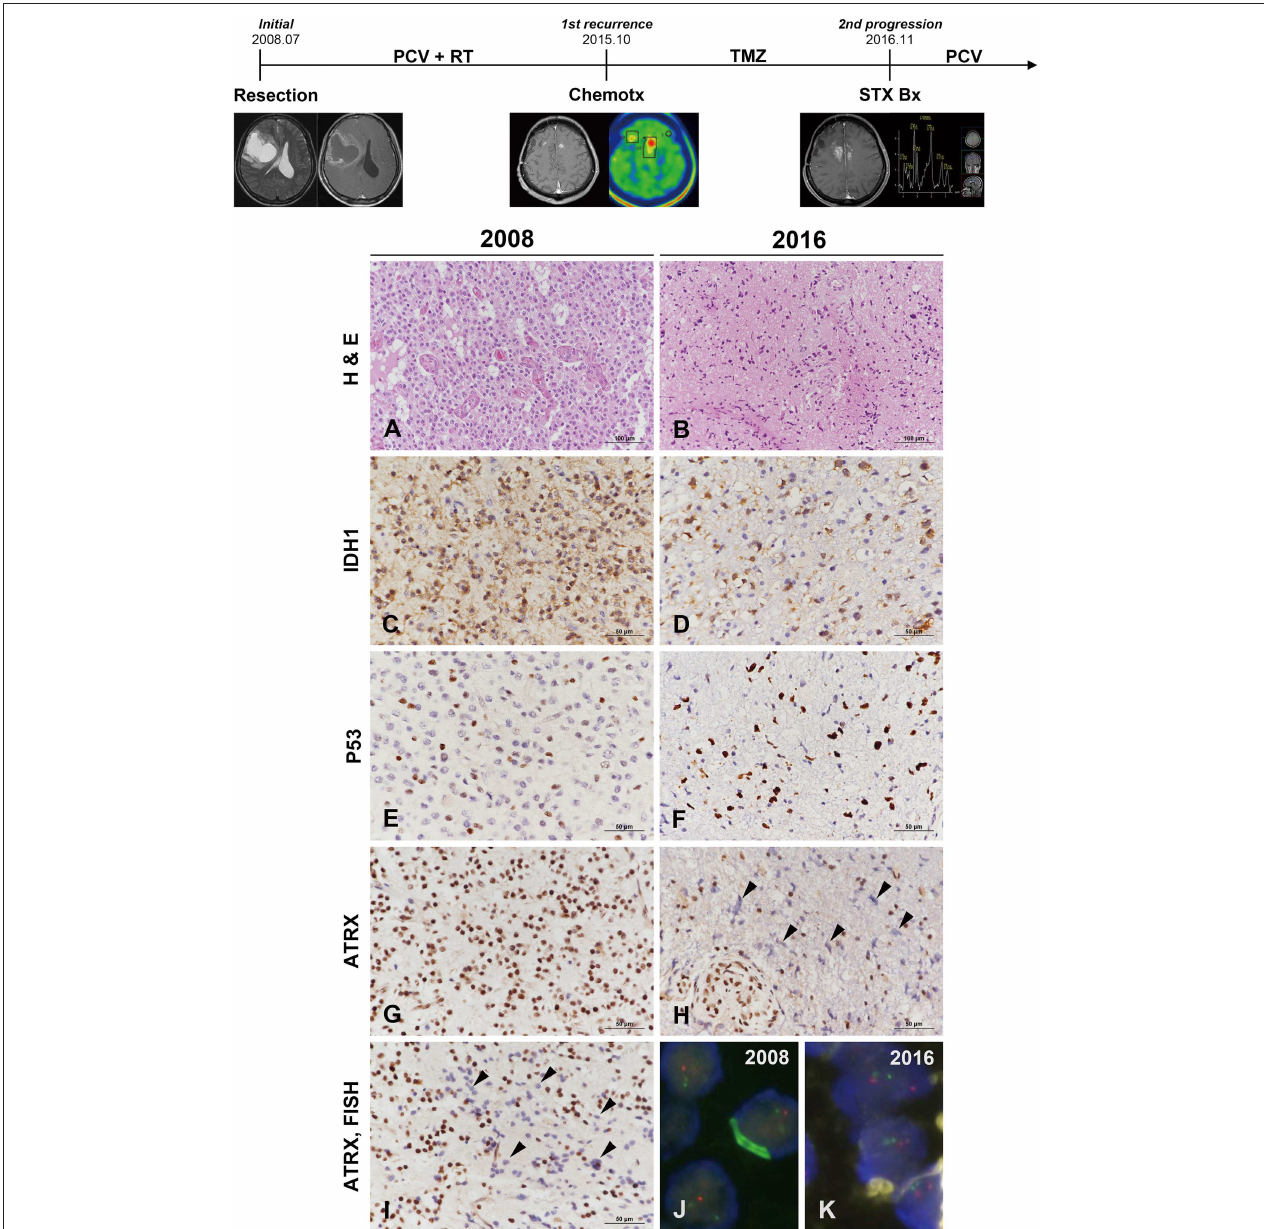
FIGURE 3 | Clinicoradiological and pathological findings in case 2. The clinical progression of case 2 is summarized in uppermost. The original lesion displayed microvascular proliferation among monotonous tumor cells with perinuclear halos in 2008 (A) and then converted to a tumor with marked cytological atypia in 2016 (B) ( A,B , hematoxylin and eosin stain; original magnification, × 200). The tumor cells showed IDH1-R132H positivity by IHC at both occasions (C,D) . P53 immunoreactivity converted from weak heterogeneous positivity of the wild type in 2008 to strong positivity of the mutant type at recurrence (E,F) . ATRX expression was strongly positive in the original tumor (G) but was lost at recurrence (H) . Similar to case 1, the specimen in 2009 demonstrated ATRX-negative cells that intermingled with the cells showing strong ATRX expression ( I , arrowheads) ( C–H,I , IHC results; original magnification, × 400). Chromosome 1 FISH performed on the 2002 specimen demonstrated loss of 1p (red) in the tumor cells (J) . Chromosome 19 FISH performed on the 2016 specimen demonstrated two copies of 19q (red) and 19p (green) in the tumor cells (K) ( J,K , FISH; original magnification, × 1,000). *ATRX, alpha-thalassemia/mental retardation X-linked; FISH, fluorescence in situ hybridization; IDH, isocitrate dehydrogenase; IHC, immunohistochemistry. genomic evolution may be presumed to occur simultaneously with the initial clonal divergence (6, 7). Genetic heterogeneity of multifocality (7). In LGG, clonal diversity or evolution